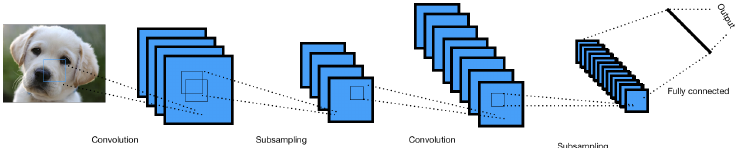
Figure 1: The general structure of a CNN with convolutional , subsampling and fully- connected layers stacked